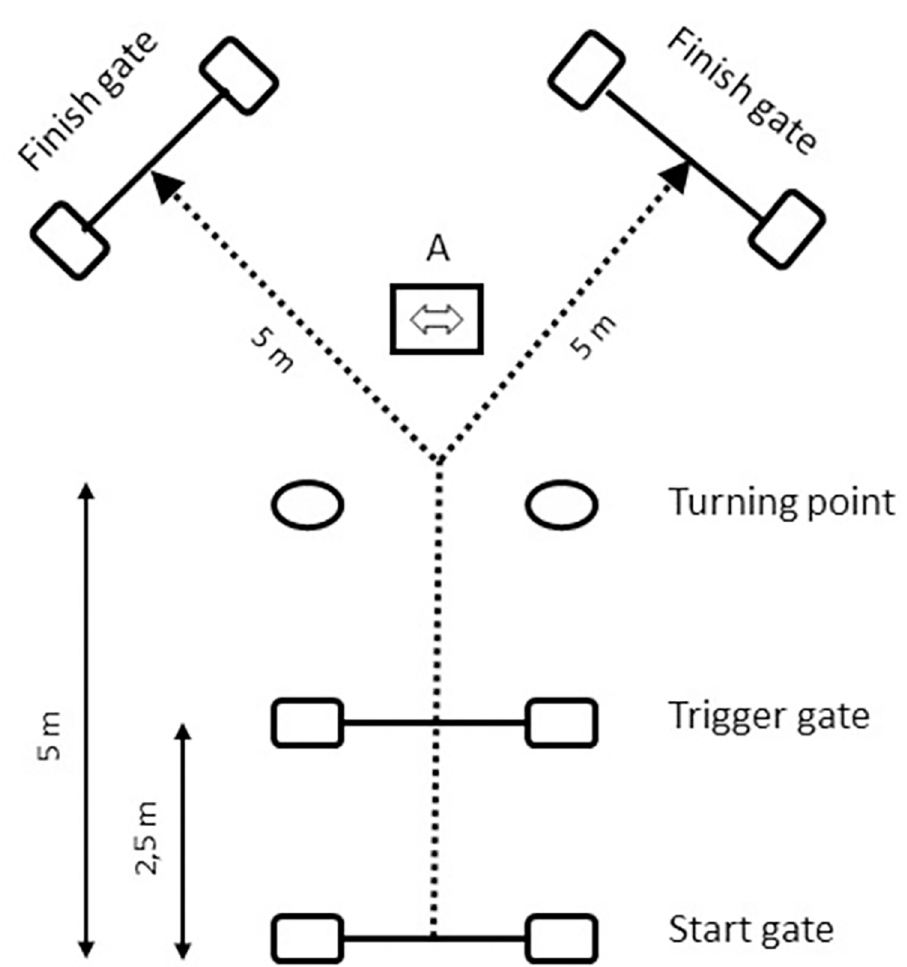
Fig 1. Y-shaped test used for the RCOD and RA protocols. For RA, a LED indicator showing the direction (A) was placed 2 m beyond the turning point, while it was not present in